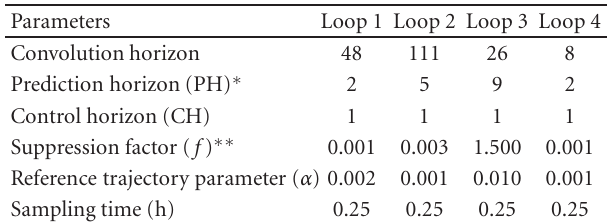
Table 5: Sensitivity analysis parameters of DMC for